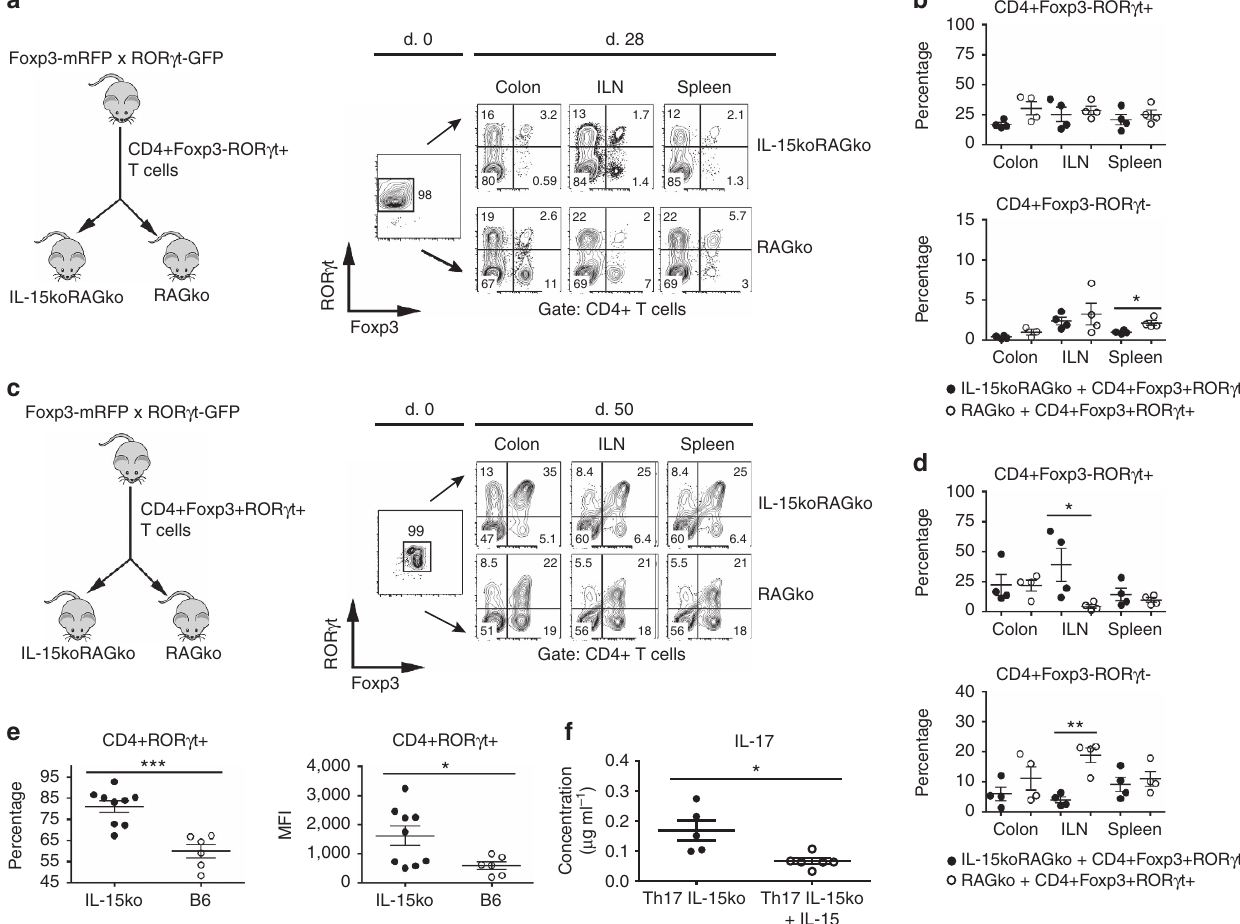
Figure 2 | IL-15 modulates the ROR c t and Foxp3 expression by CD4 þ T cells. ( a ) About 10 5 ROR g t þ (Foxp3-) CD4 þ T lymphocytes from Foxp3- mRFPxROR g t–GFP mice were transferred into RAG2ko or IL-15koRAG2ko mice killed 28 days later: ROR g t and Foxp3 expression by CD4 þ Tcells before (day 0, left panel) and after transfer in the injected RAG2ko and IL-15koRAG2ko mice (day 28, right panel). ( b ) Percentage among live CD4 þ T cells of Foxp3-ROR g t þ CD4 þ T cells (upper panel) and Foxp3 þ ROR g t-CD4 þ T cells (lower panel) in RAG2ko or IL-15koRAG2ko recipients. ( c ) About 10 5 Foxp3 þ ROR g t þ CD4 þ T cells from Foxp3-mRFP (cid:3) ROR g t–GFP mice were transferred into RAG2ko or IL-15koRAG2ko mice killed 50 days later: ROR g t and Foxp3 expression by CD4 þ Tcells before (day 0, left panel) and after transfer in RAG2ko or IL-15koRAG2ko hosts (right panel). ( d ) Frequency among live CD4 þ Tcells of Foxp3-ROR g t þ CD4 þ Tcells (upper panel) and Foxp3 þ ROR g t-CD4 þ Tcells (lower panel) after transfer. ( b – d ) Data compiled from two separate experiments with at least two mice per group. Black circles represent IL-15koRAG2ko hosts, open circles RAG2ko hosts. ( e ) Naive CD4 þ T lymphocytes from IL-15ko (black circles) or B6 mice (open circles) were cultured 4 days in vitro under Th17-polarizing conditions: percentage among live CD4 þ Tcells (left) and mean fluorescence intensity (MFI, right) of ROR g t-expressing CD4 þ Tcells in the culture. ( f ) Naive CD4 þ T lymphocytes from IL-15ko mice were cultured like in e in presence or absence of recombinant IL-15: concentration of IL-17 measured by ELISA in cell culture supernatants. ( e , f ) Data compiled from two separate experiments with at least three mice per group. Each symbol represents an individual mouse. All graphs indicate means; error bars denote s.e.m.; Student’s t -test values: * P o 0.05; **0.01 o P o 0.05; *** P o